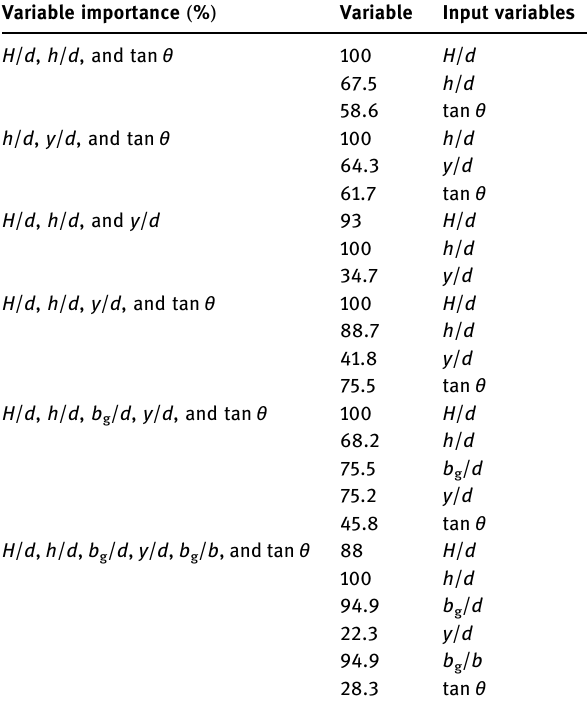
Table 2: Results of normalized variable